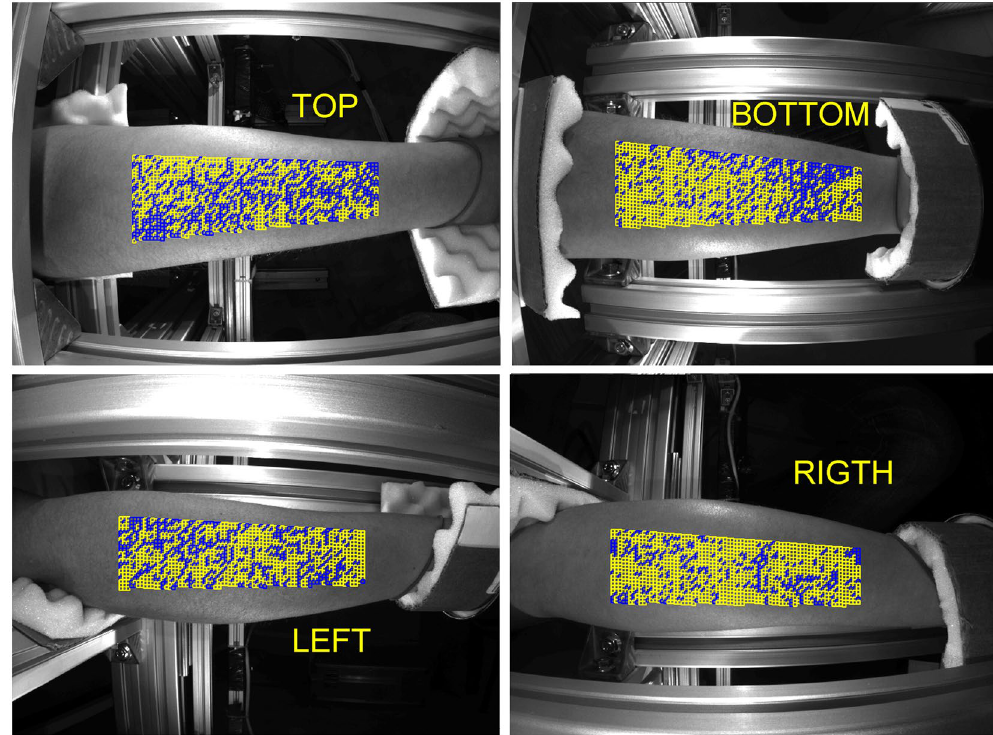
Figure 3. Spatial distribution of the good ROIs in four views of the forehand. Yellow and blue squares show positions of the ROIs with linear and distorted PPG waveforms, respectively.